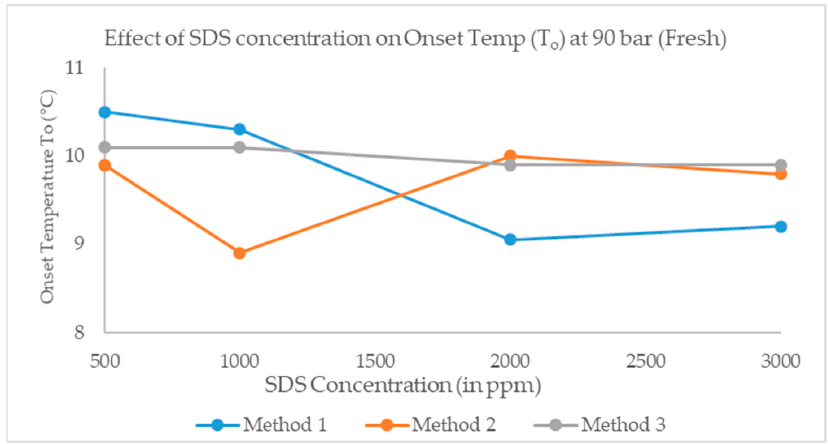
Figure 6. Onset temperature T o versus SDS concentration for freshwater (method 1, method 2 and method